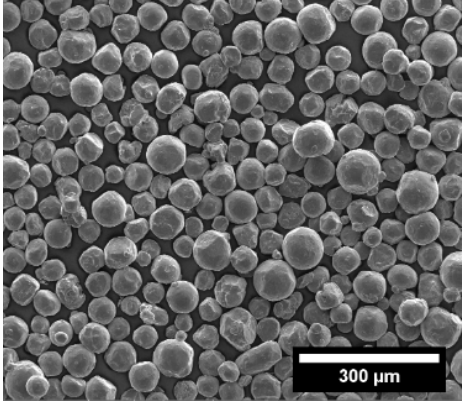
Figure 1. The morphology of the Ti powder used .